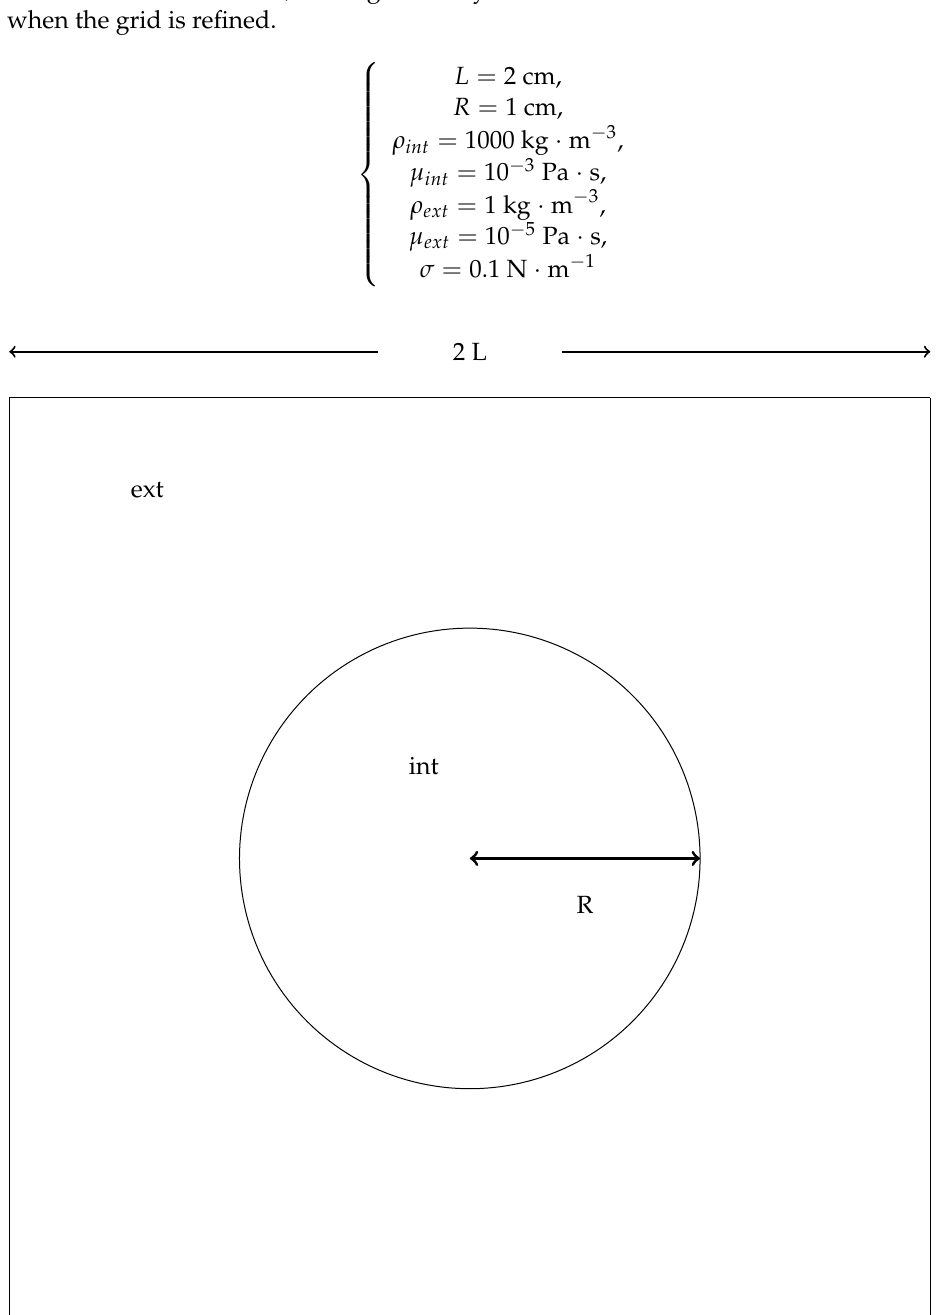
Figure 5. Test case of the static bubble with parasitic